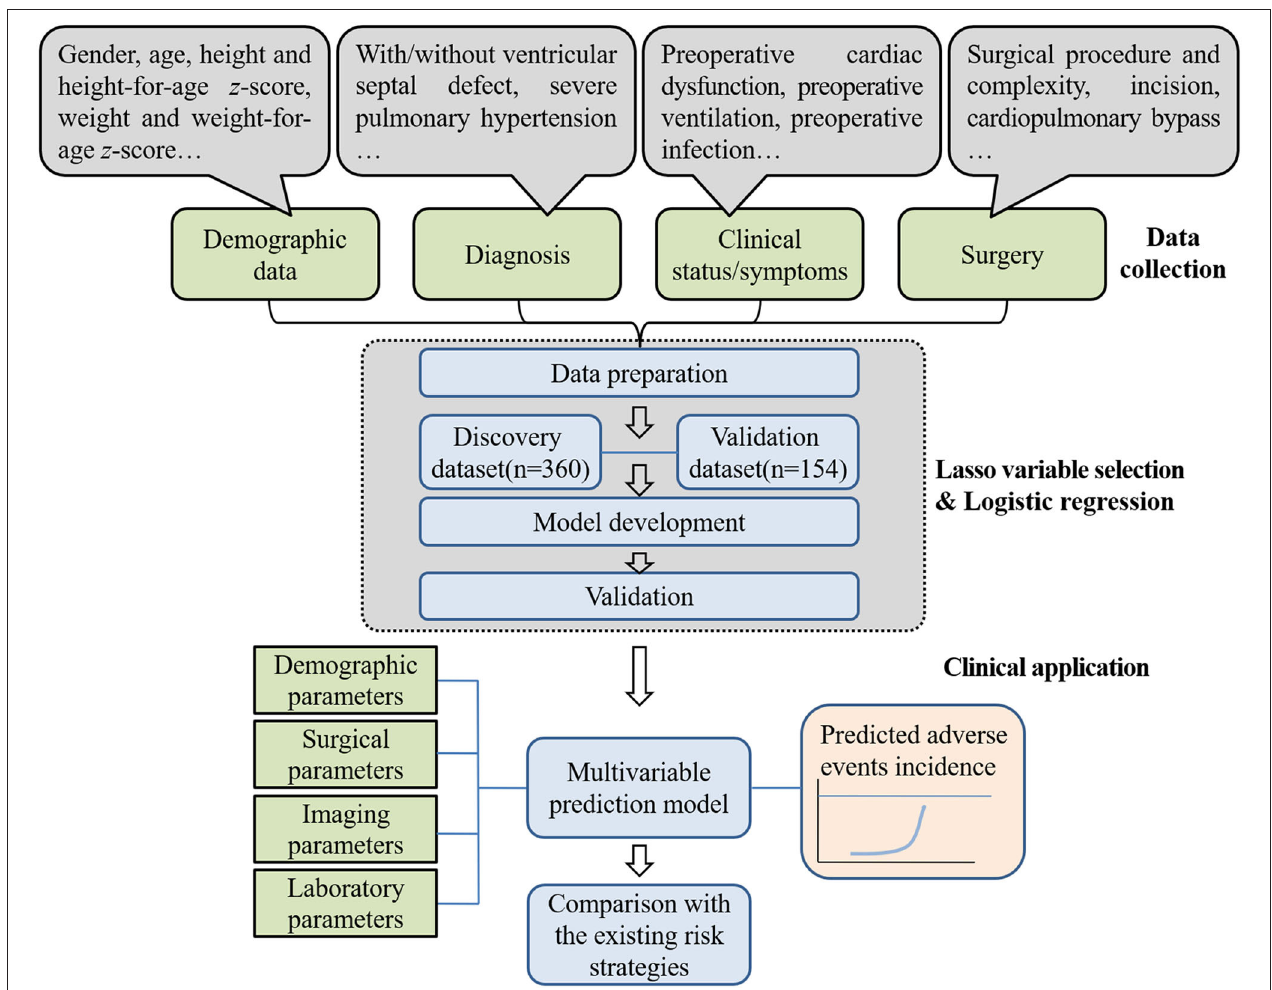
FIGURE 1 | Overview of the phases we have followed to construct the predictive model. The Lasso method used clinical data input and selected predictor variables. In the end, a postoperative risk modeled for 30-day or in-hospital adverse events after operation was developed that including multiple variables contained prognostic information. The performance of the newly developed model was compared with that of the existing risk strategies. The speech bubbles illustrate the type of input used in the Lasso method. The input examples shown are from parts of the candidate